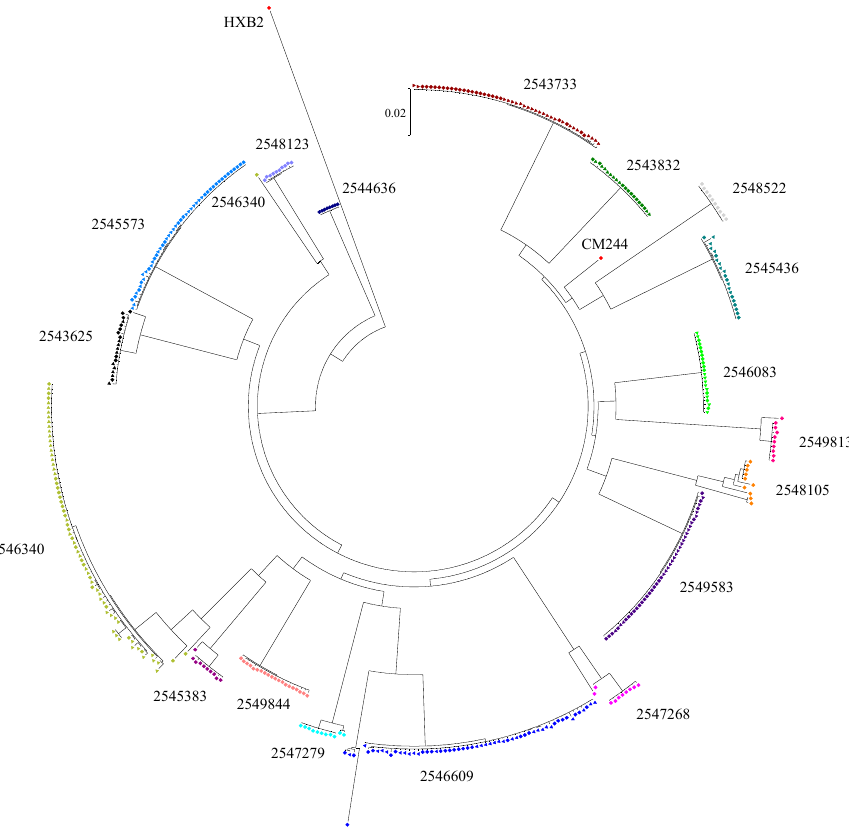
Figure 1. Maximum likelihood tree of envelope gp160 gene sequences. Sequences were retrieved from participant plasma (circle symbol) and cerebrospinal fluid (CSF) (triangle symbol). Reference sequences include HXB2 and CM244 (GenBank accession K03455 and AY713425, respectively).